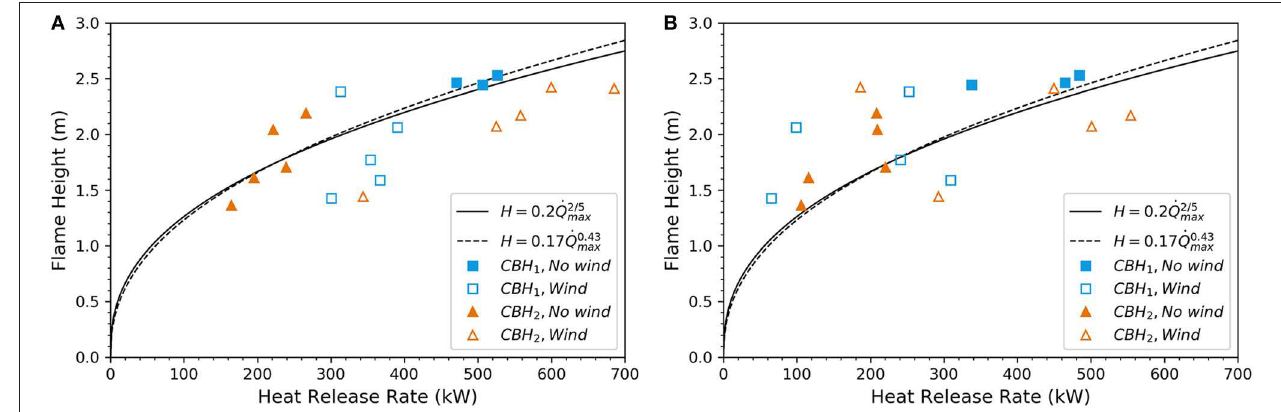
)]. (B) Method 2, ˙ Q max obtained from max